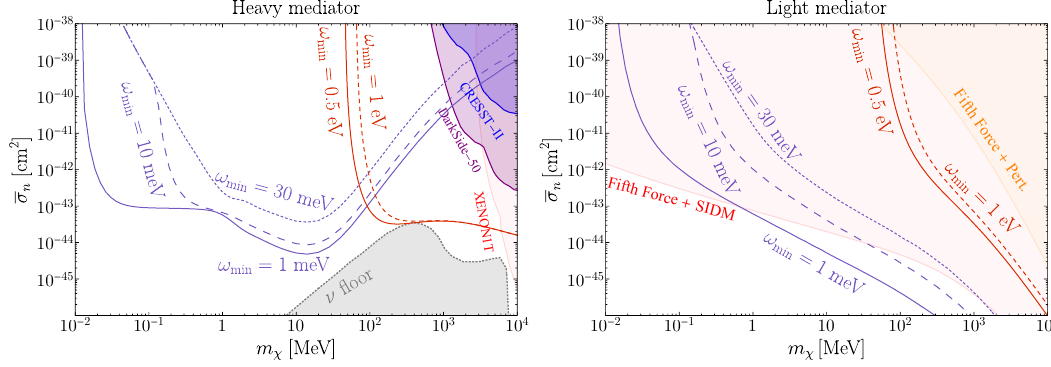
Figure 4 . Projected reach for DM scattering via a heavy (left, m (cid:30) & 400 MeV) or light (right, m (cid:30) = 1 eV) scalar mediator coupling to nucleons ( f p = f n , f e = 0), assuming 1 kg-yr exposure with a GaAs target, 3 signal events and no background. Both single phonon production (purple, assuming energy thresholds ! min = 1 ; 10 ; 30 meV) and nuclear recoils (red, assuming ! min = 0 : 5 ; 1 eV)